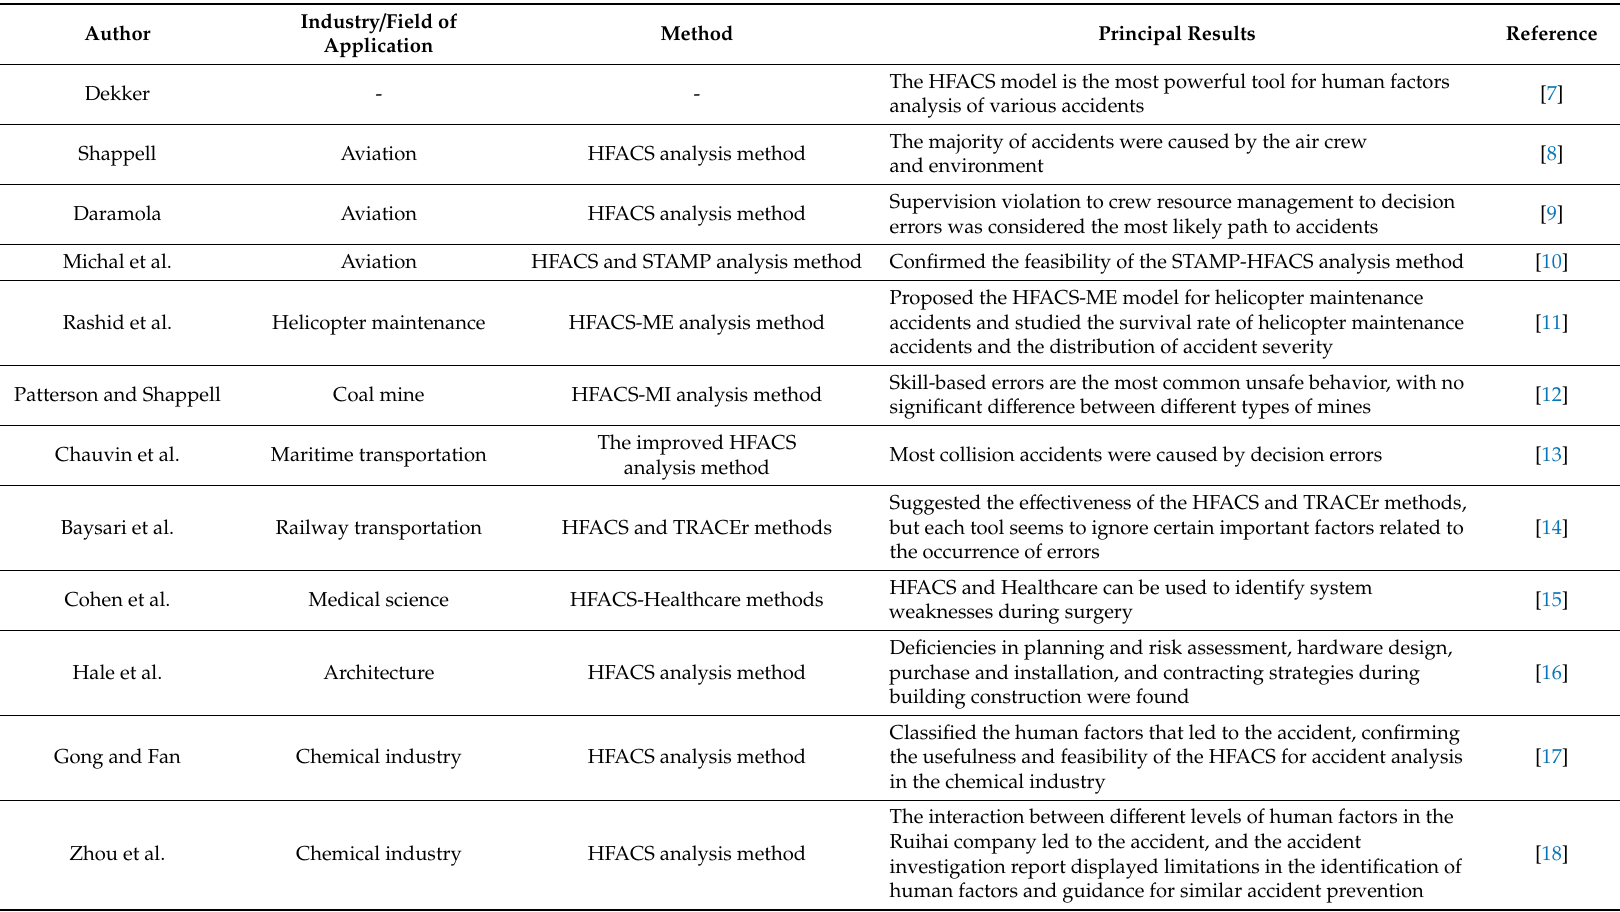
Table 1. Review of the main relevant information of the human factors analysis and classification system